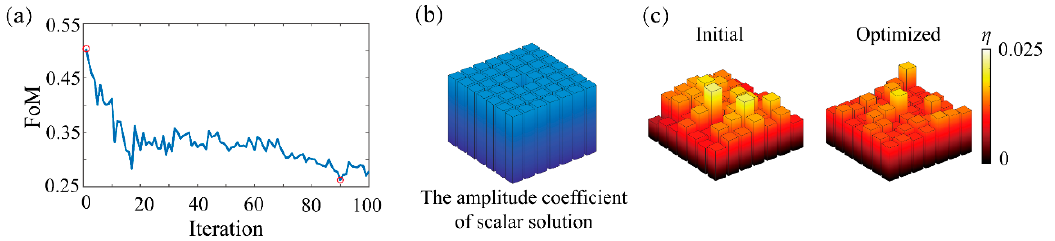
Figure 4. A plot of the relationship of the S 0 , the S (cid:48) array and a maximal diffraction angle of 35 ◦ . The S 0 is obtained from the initial solutions. The S (cid:48) from the optimal solutions. All the 40 samples have been optimized for 100 iterations.